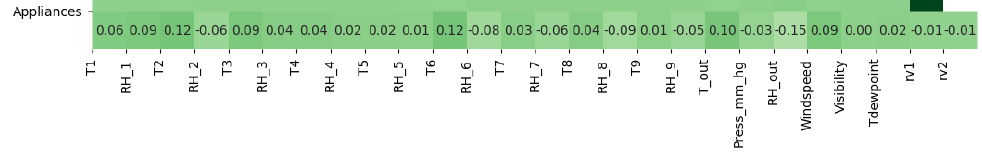
Figure 5. Feature